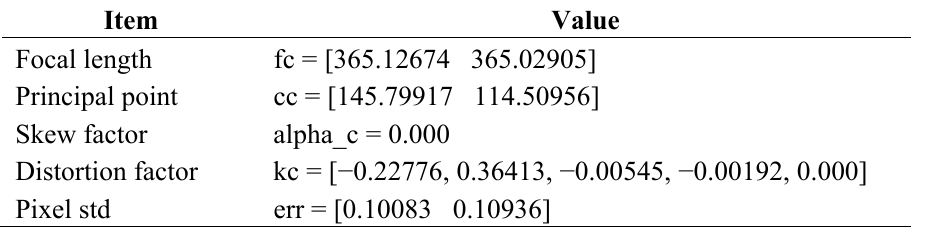
Table 1. Intrinsic Parameters.